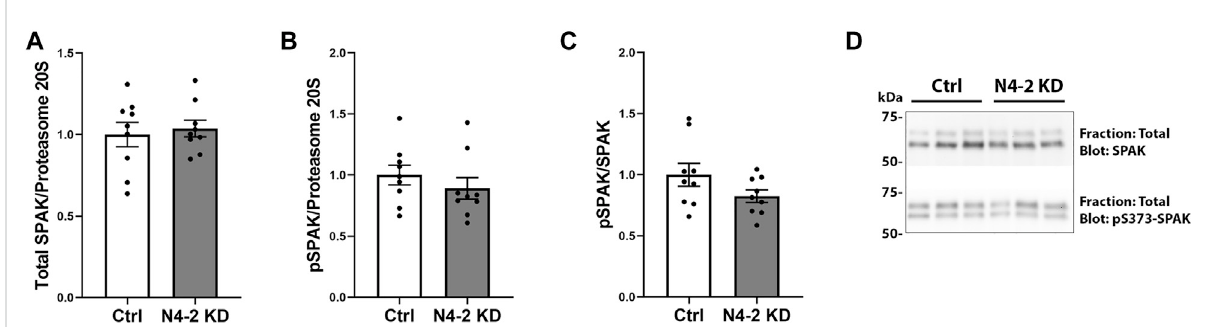
FIGURE 4 Nosigni fi cantdifferenceinSPAKandphosphorylated SPAK(pS373-SPAK)arefoundinMDCKI-hNCCcellswith Nedd4-2KD.Semi-quantitative assessment of SPAK (A) , pS373-SPAK (B) , and pS373-SPAK/SPAK ratio (C) in total cell lysates of MDCKI-hNCC Ctrl and Nedd4-2 (N4-2) KD cell lines. Data are means ± S.E.M. ( n = 9) * p < 0.05 assessedby unpairedStudent ’ s t-test. (D) Representative blots of SPAKand pS373-SPAKin total cell lysates of MDCKI-hNCC Ctrl and N4-2 KD cell